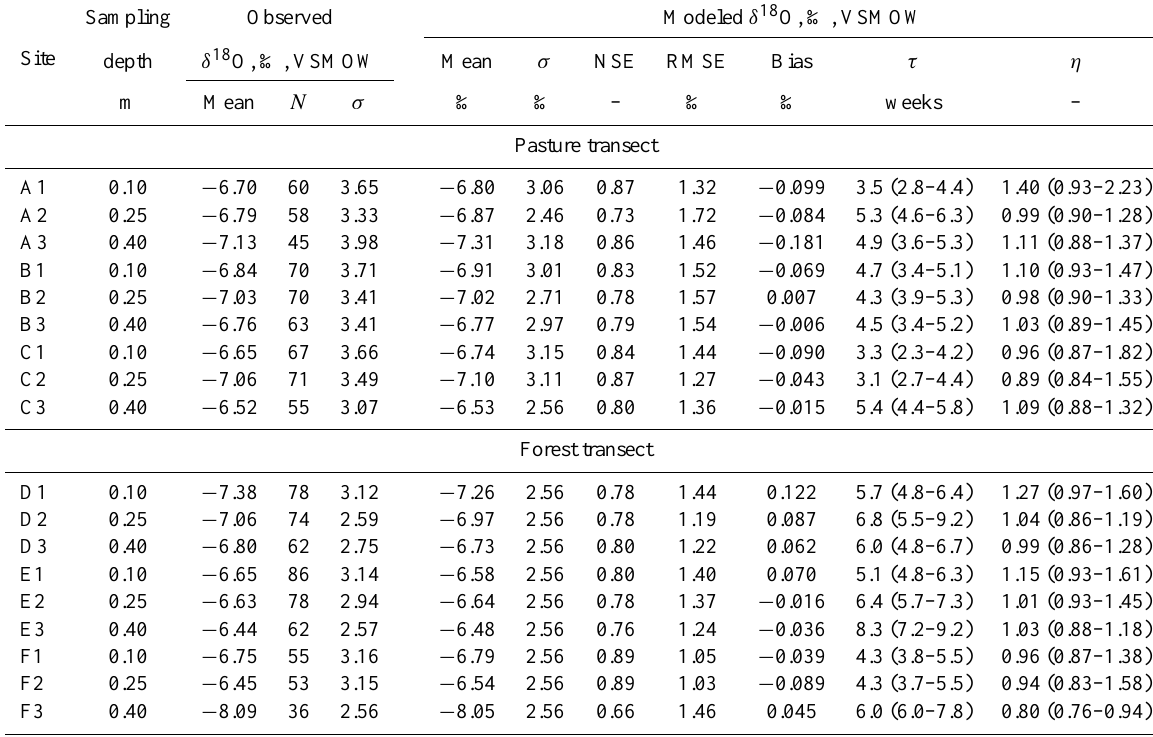
Table 4. Main statistical parameters of observed δ 18 O and predicted results for soil waters using a LPM distribution function. Statistical parameters of modeled results: RMSE, bias, mean and σ correspond to the best-matching value of the objective function NSE. Uncertainty bounds of modeled parameters ( τ and η ), calculated through generalized likelihood uncertainty estimation (GLUE), are shown in parenthesis.